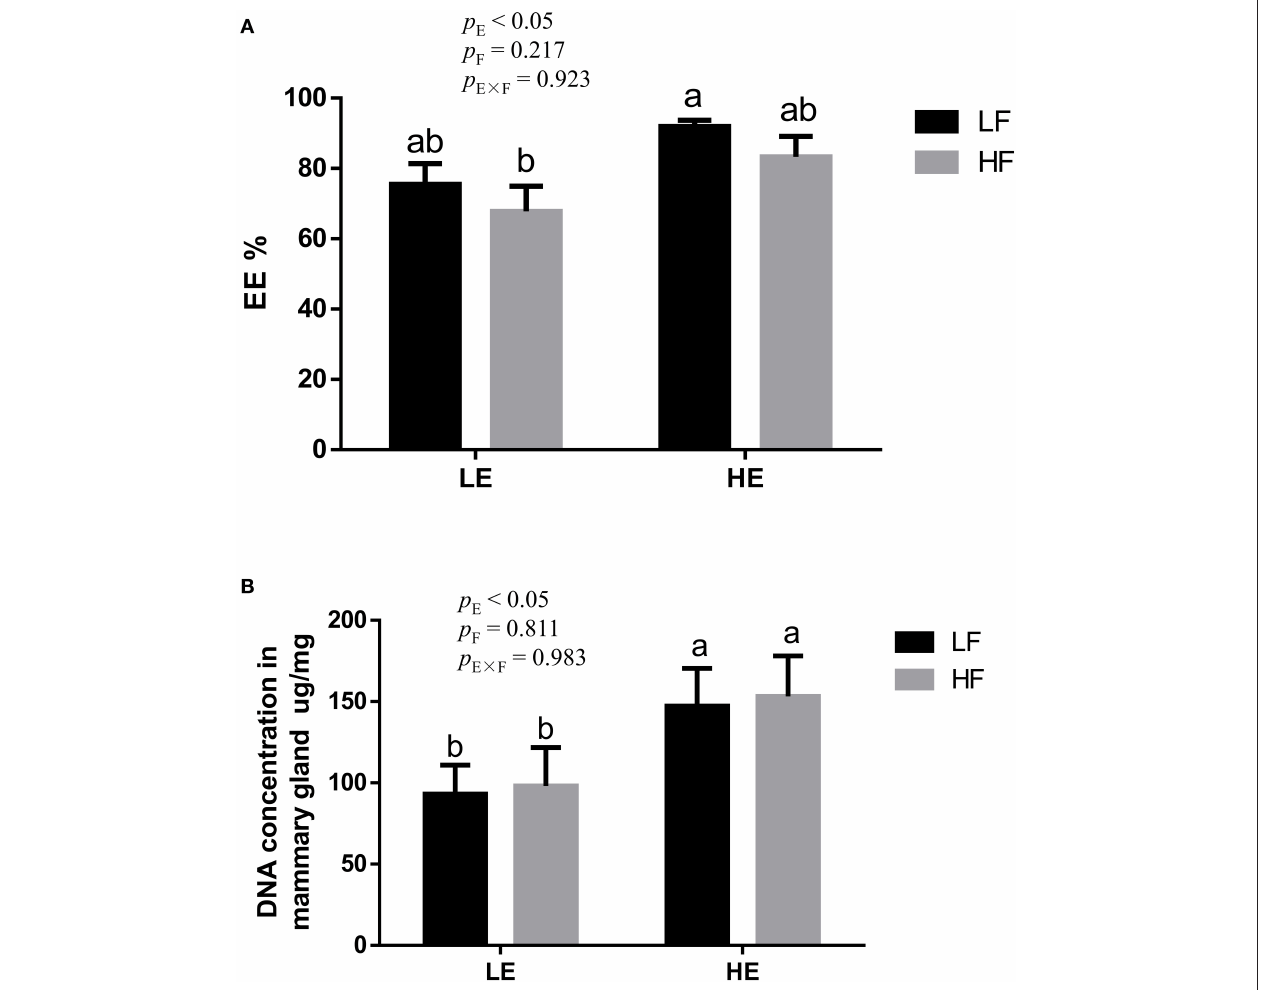
FIGURE 2 | Effects of energy and fiber interaction on crude fat (A) and DNA (B) concentration in mammary gland of gilts (n = 8). LELF, low-energy low-fiber group; LEHF, low-energy high-fiber group; HELF, high-energy low-fiber group; HEHF, high-energy high-fiber group; E × F, energy and fiber interaction. a,b Means not sharing identical superscripts are significantly different ( p <